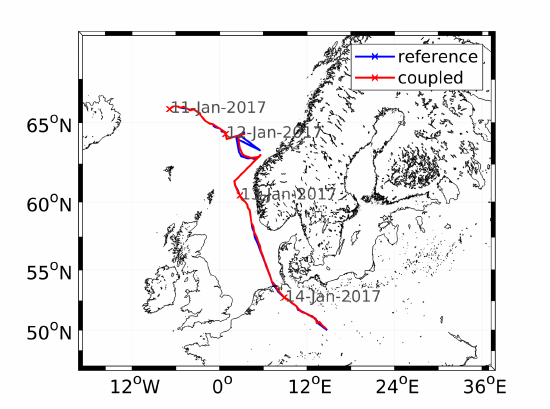
Figure 9. Track of the low-pressure system from 11 January 2017 to 15 January 2017 for the reference model simulation (blue) and the coupled model simulation